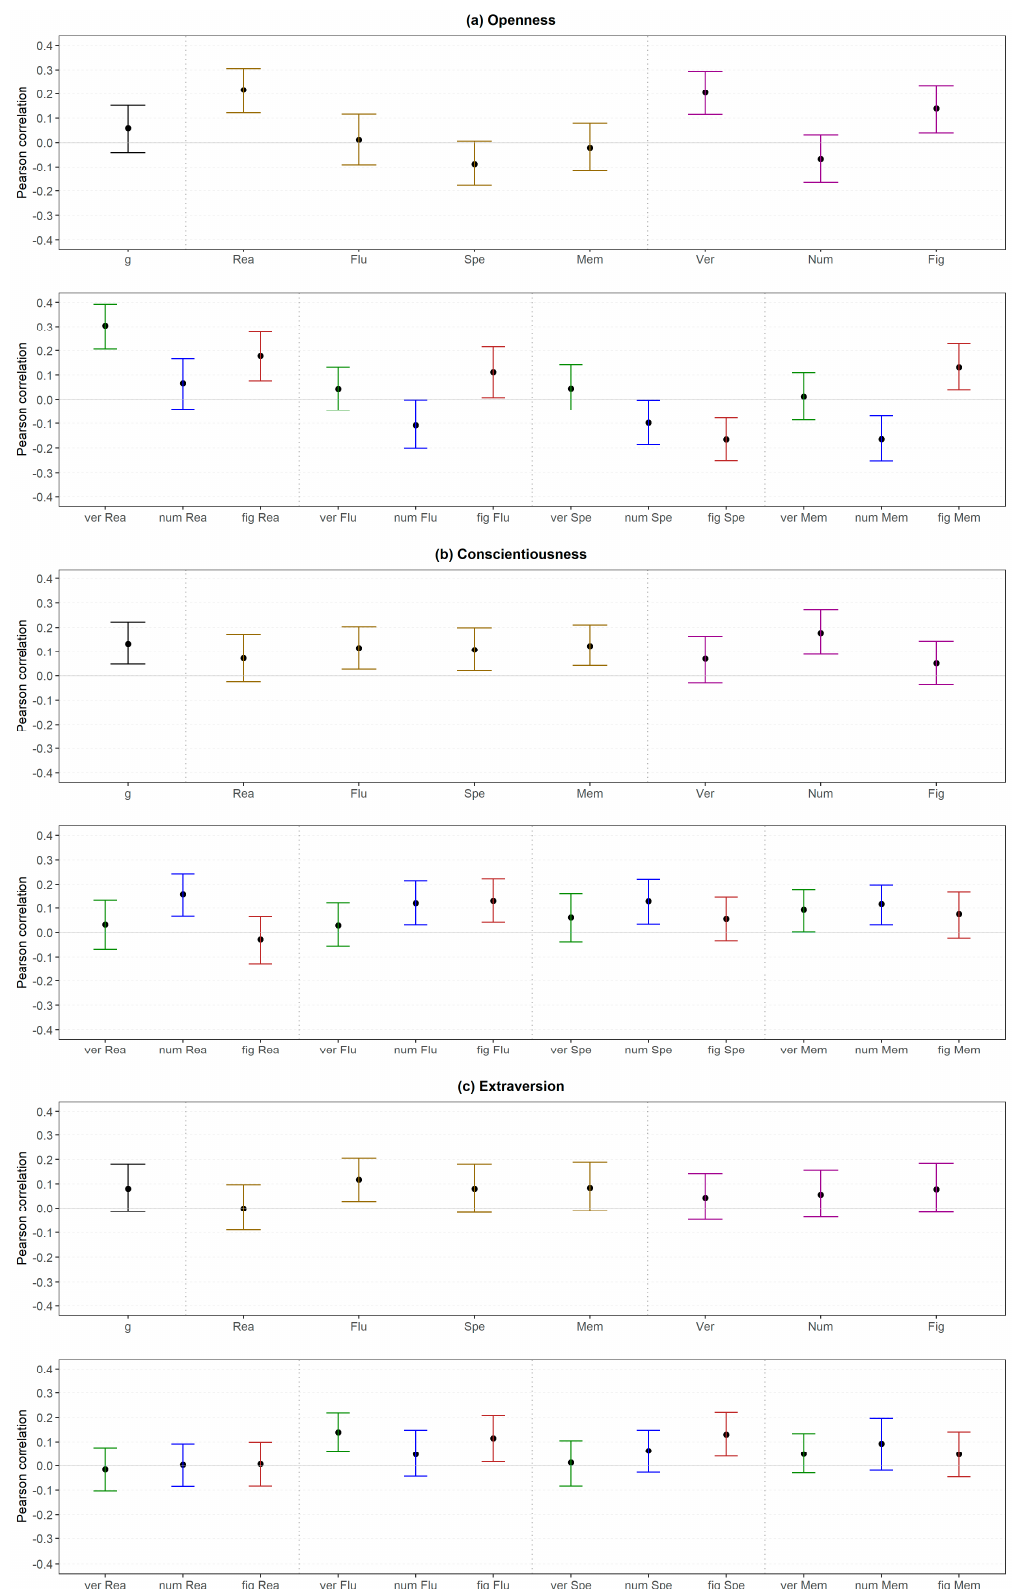
Figure 11. Study 2: Correlations between intelligence and ( a ) Openness, ( b ) Conscientiousness and ( c ) Extraversion. Rea = reasoning, Flu = fluency, Spe = perceptual speed, Mem = memory, Ver = verbal (intelligence), Num = numerical (intelligence), Fig = figural (intelligence).